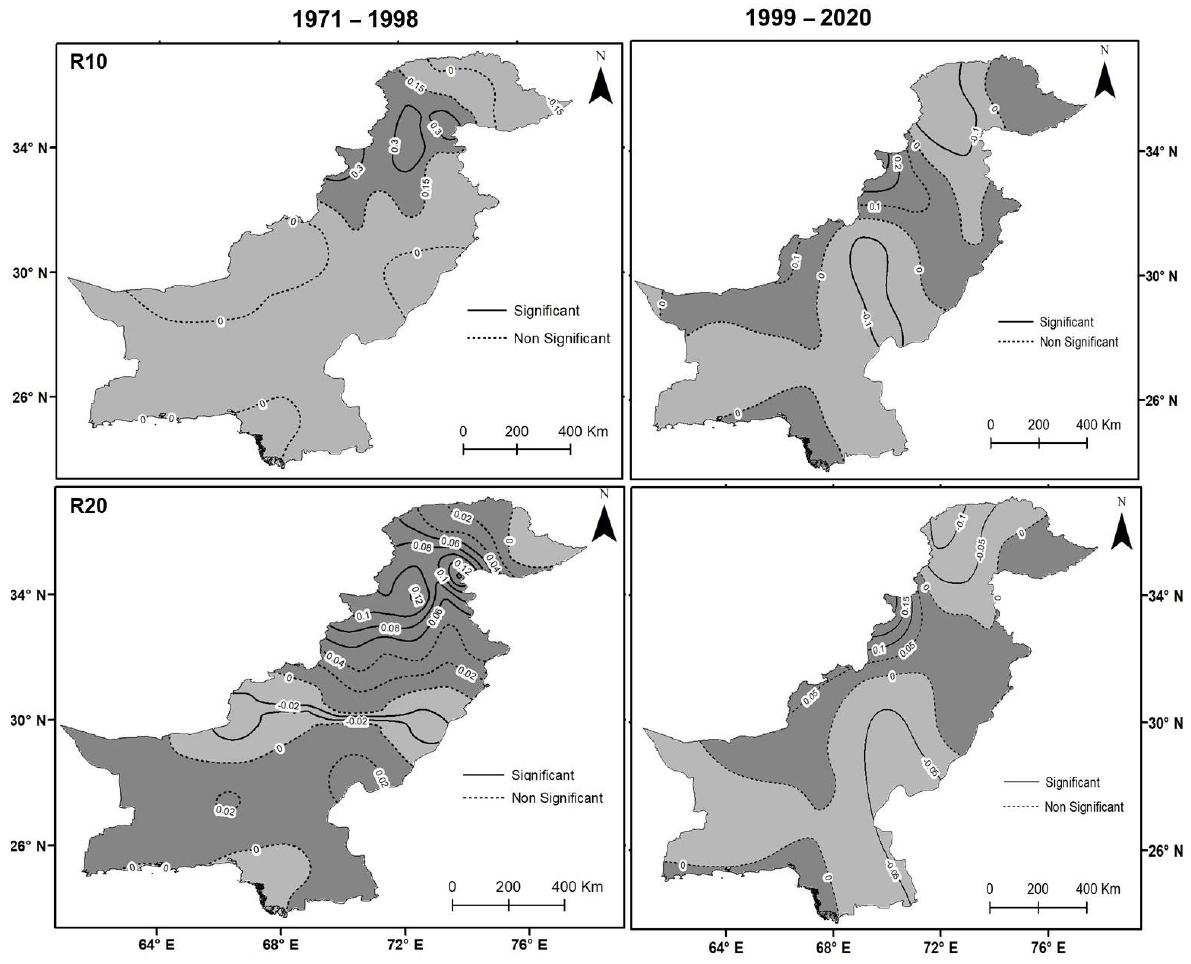
Figure 5. Spatial trends for extreme precipitation indices R10 and R20 (days) between 1971 and 1998 as well as 1999 and 2020. Dark color indicates the positive changes and light color shows the negative changes at 0.05 level of significance.